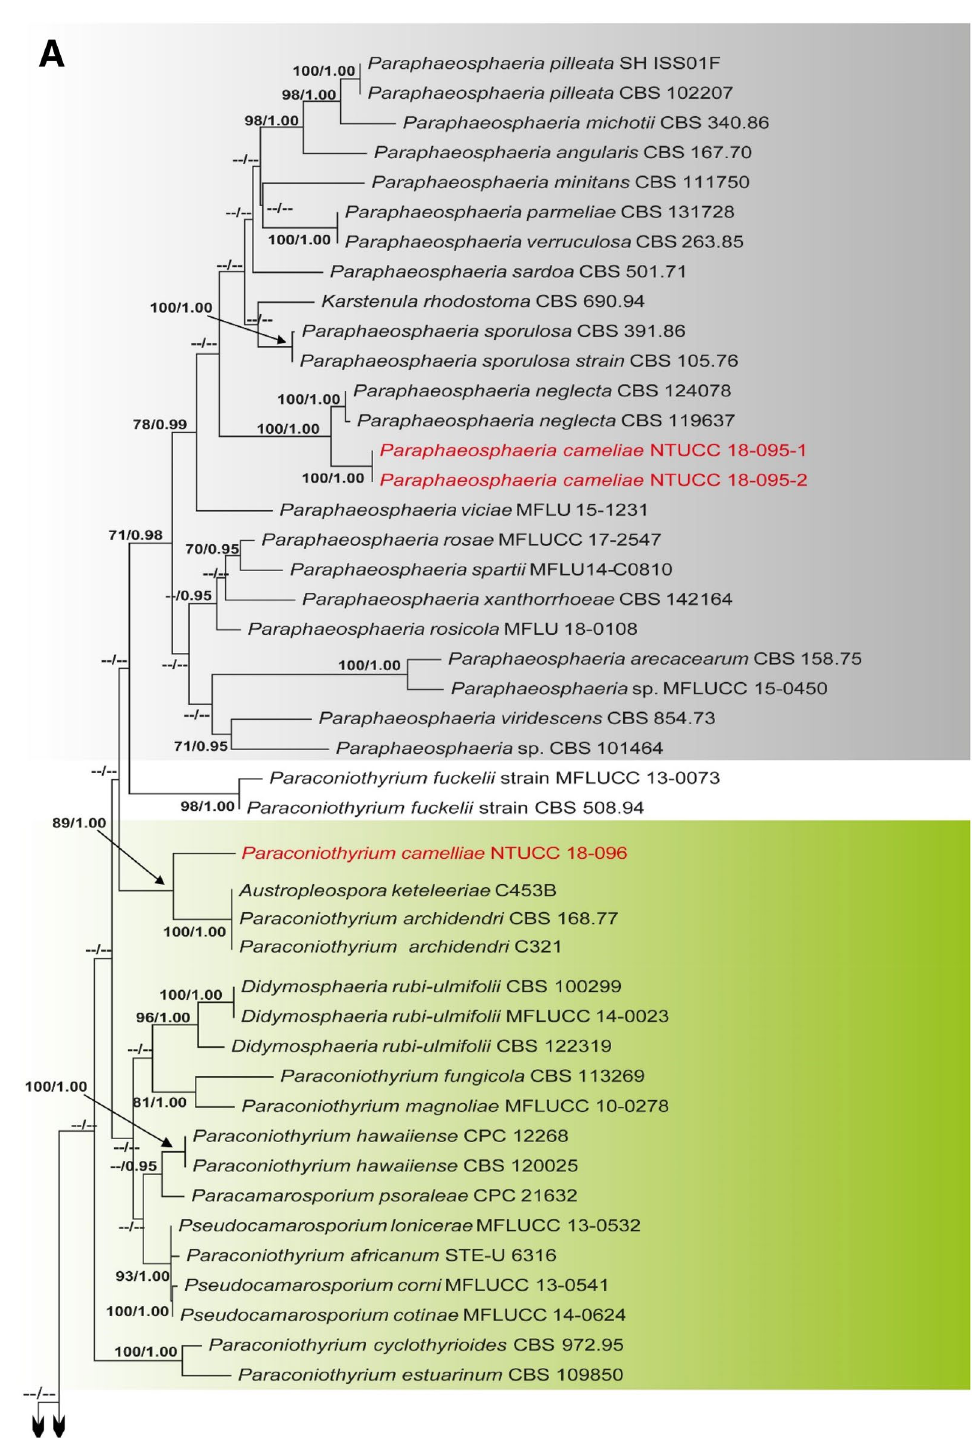
Figure 2. ( A ) Part one of the phylogenetic tree based on the concatenated alignment of four molecular markers (ITS, LSU, SSU, and tub 2) evaluated using RAxML. The new isolates are shown in red. ML bootstrap values (MLBS) ≥ 70% and Bayesian posterior probabilities (PP) ≥ 0.95 are at each node. The scale bar indicates the number of estimated substitutions per site. Cucurbitaria berberidis (CBS 130007) and Coniothyrium palmarum (CBS 400.71) were used as outgroups for rooting the tree. ( B ) Part two of the phylogenetic tree based on the concatenated alignment of four molecular markers (ITS, LSU, SSU, and tub 2) evaluated using